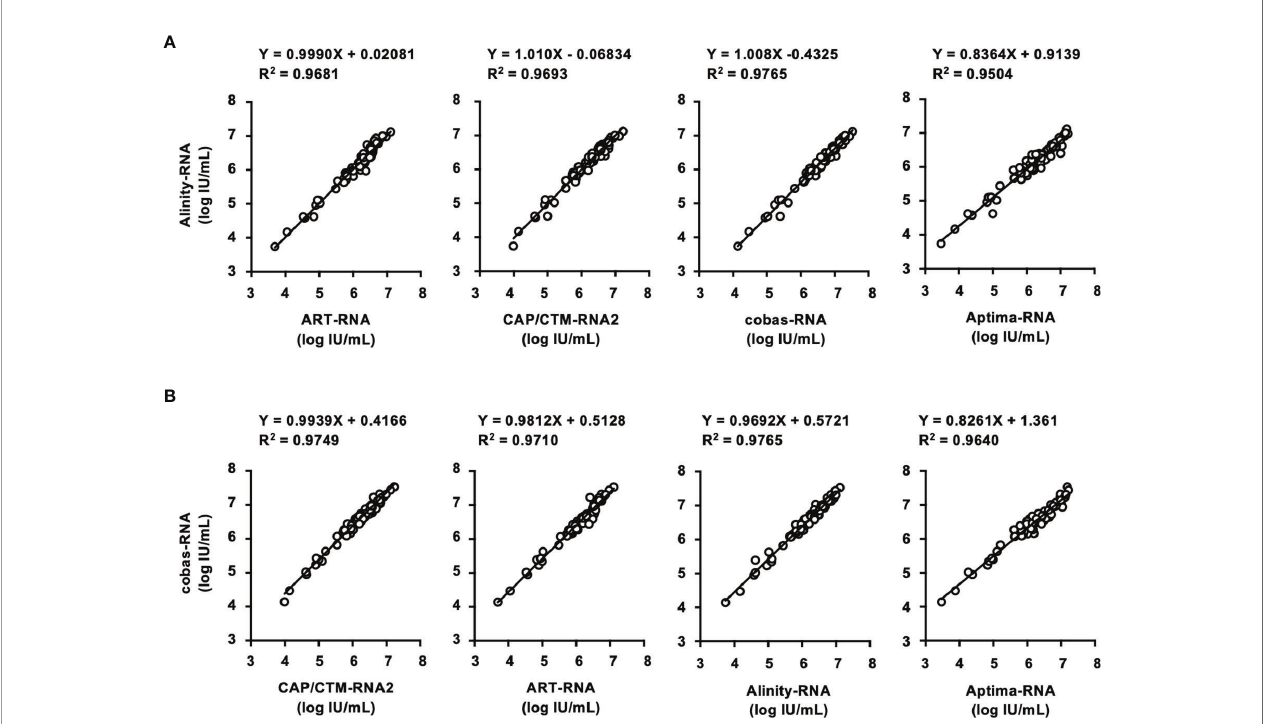
FIGURE 2 | Evaluation of HCV-positive specimens in the regional reference panel by HCV RNA quanti fi cation kits. (A) Correlation of quanti fi ed HCV RNA titers between Alinity-RNA and ART-RNA, CAP/CTM-RNA2, cobas-RNA, and Aptima-RNA. The correlation equation and the R 2 value are indicated at the top of the panel. (B) Correlation of quanti fi ed HCV RNA titers between cobas-RNA and CAP/CTM-RNA2, ART-RNA, Alinity-RNA, and Aptima-RNA. The correlation equation and the R 2 value are indicated at the top of the